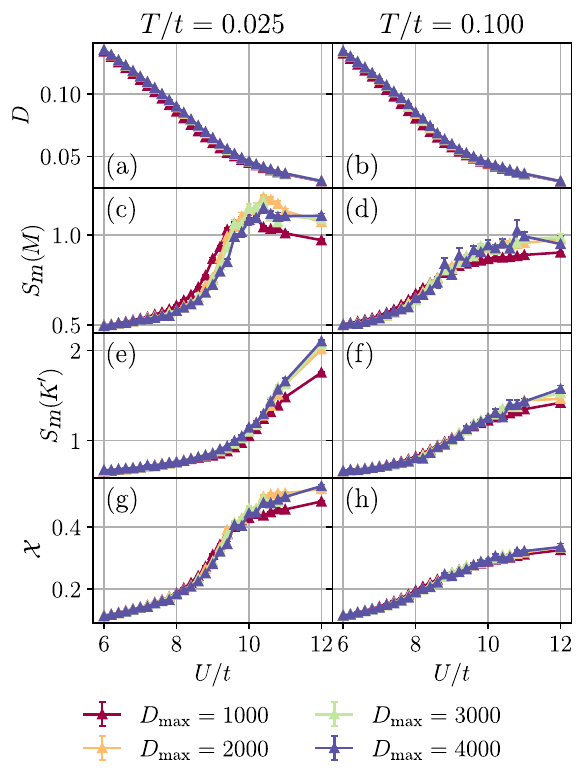
FIG. 8. Convergence of METTS results on the 16 × 4 YC4 cylinder as a function of maximal bond dimension D . We max 1000 , compare results from simulations performed with D max ¼ 2000, 3000, 4000. Results agree for all quantities within error 2000 , 3000, 4000, whereas results at D bars for D max ¼ max ¼ 1000 deviate slightly. Comparisons are performed at T=t ¼ 0 . 025 (left) and T=t ¼ 0 . 1 (right). We show the double occupancy D (a),(b), the magnetic structure factors evaluated at M (c),(d) and K 0 (e),(f), and the chiral susceptibility X